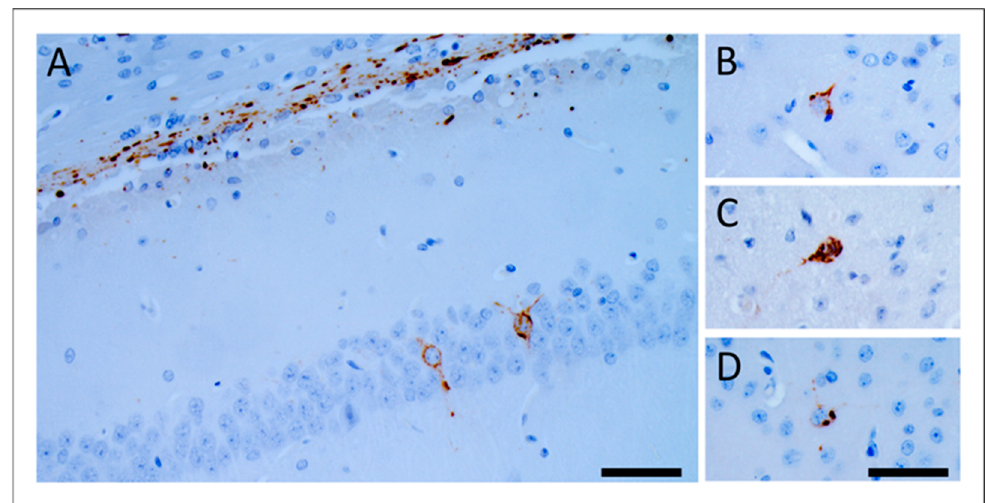
Figure 2. Tau pathology in bank voles inoculated with GSS-F198S. Hyperphosphorylated Tau ag- gregates in the brain of a BvM culled at 442 d.p.i., inoculated with GSS-F198S #3. Tau inclusions accumulated along the alveus (picture ( A ), scale bar 200 µm). In pictures ( B , C ), hyperphosphory- lated Tau depositions are shown as neuropil threads (arrows) and coiled bodies (head arrows) (scale bar 50 µm). Immunostaining was performed with AT8 antibody.